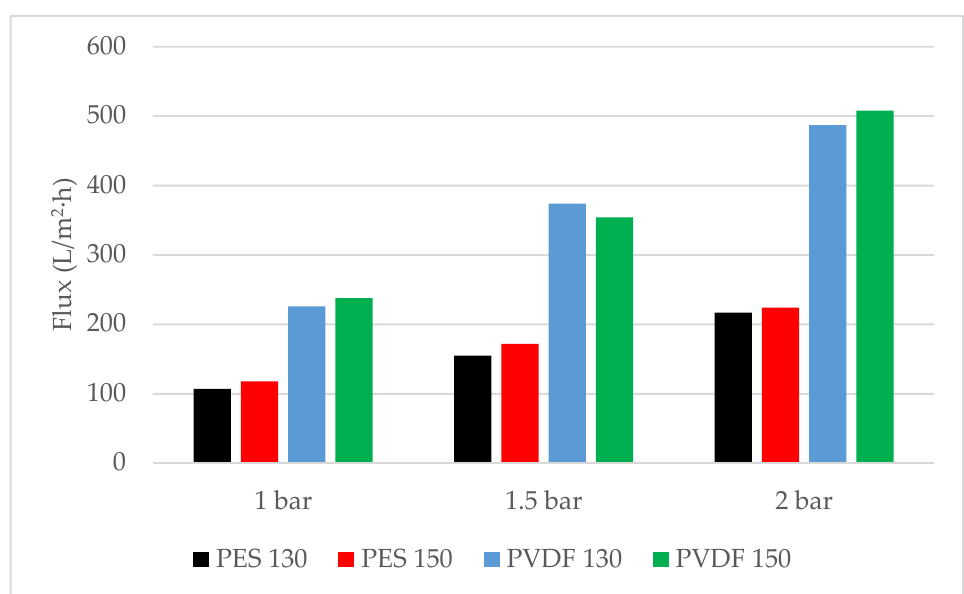
Figure 9. Flux values of membranes at different pressures.